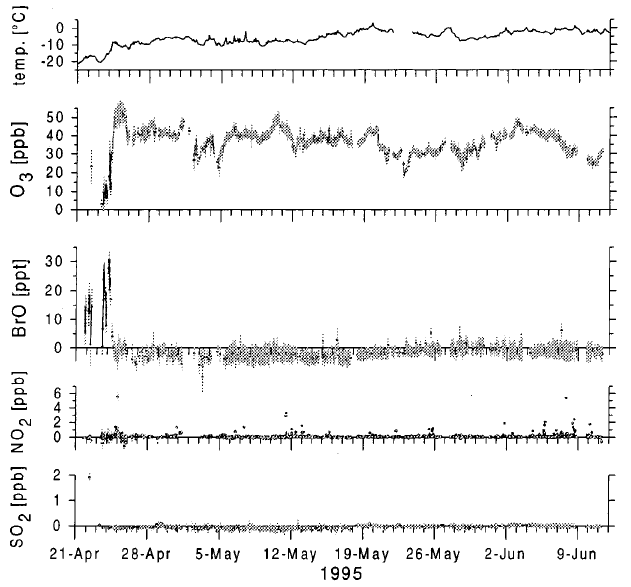
Fig. 5. ARCTOC 1995: RO x -box signals ( solid line ) calibrated corresponding to RO x (cid:135) HO x together with J(NO 2 ) from Zeppelin Station ( dotted line )